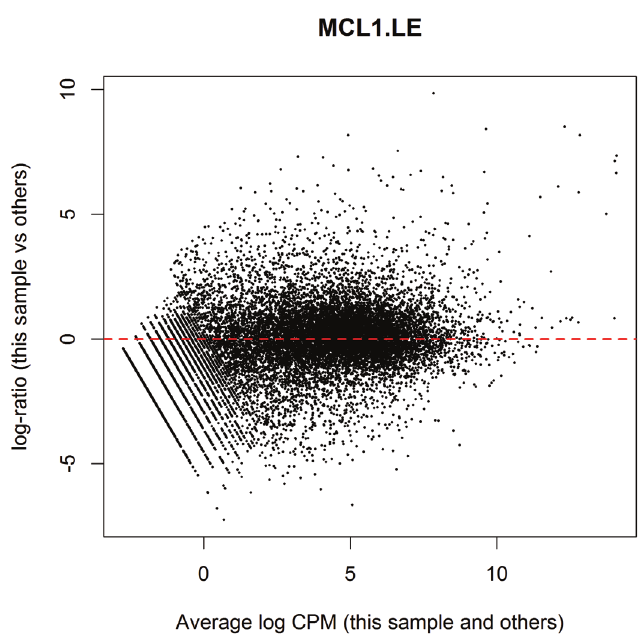
Figure 3. MD plot of log2-expression in sample 11 versus the average log2-expression across all other samples. The plot shows a number of genes that are both highly expressed and highly